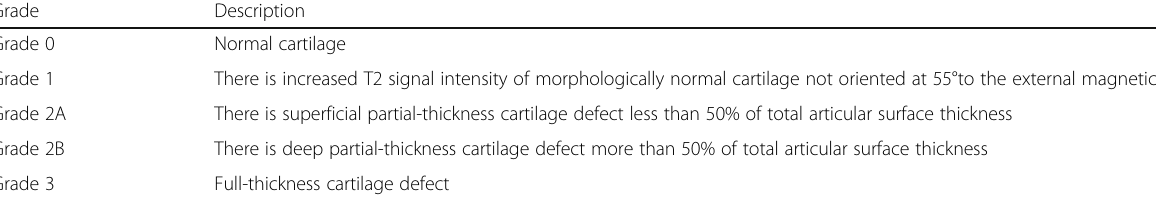
Table 2 Modified Noyes grading system for cartilage grading according to MRI abnormalities appearance [11, 12]